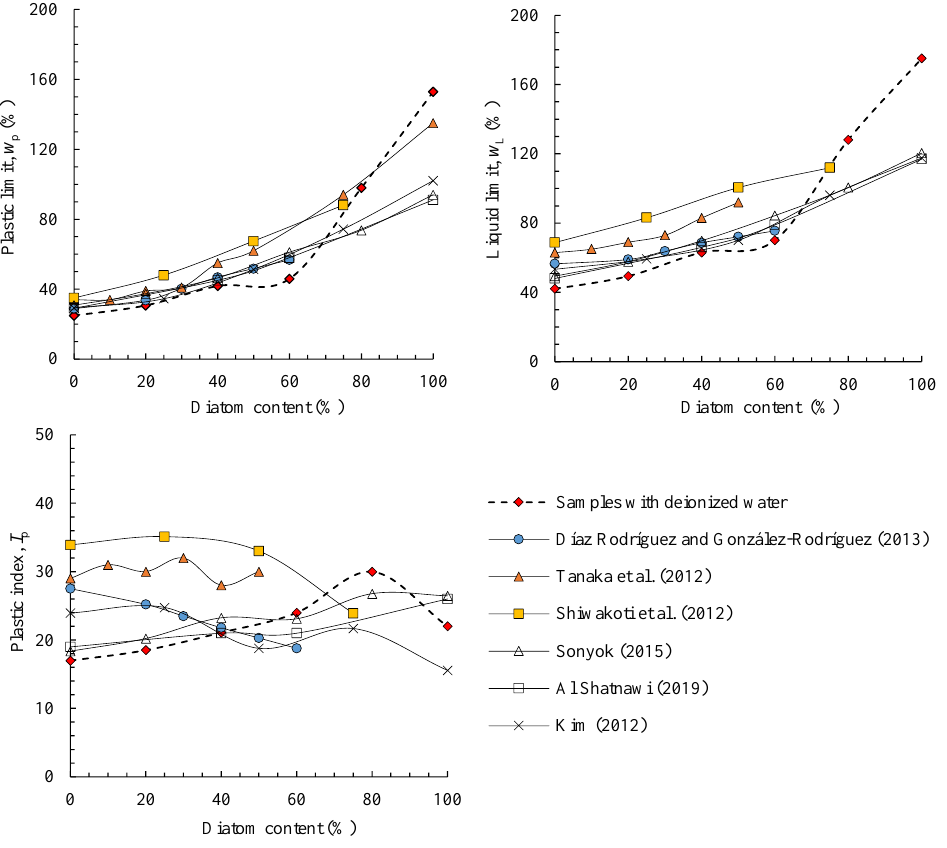
Figure 6. Values of w p , w L , and I P for DKM samples versus diatom content. Data sources: [6,12,31 – 34]. DKMs